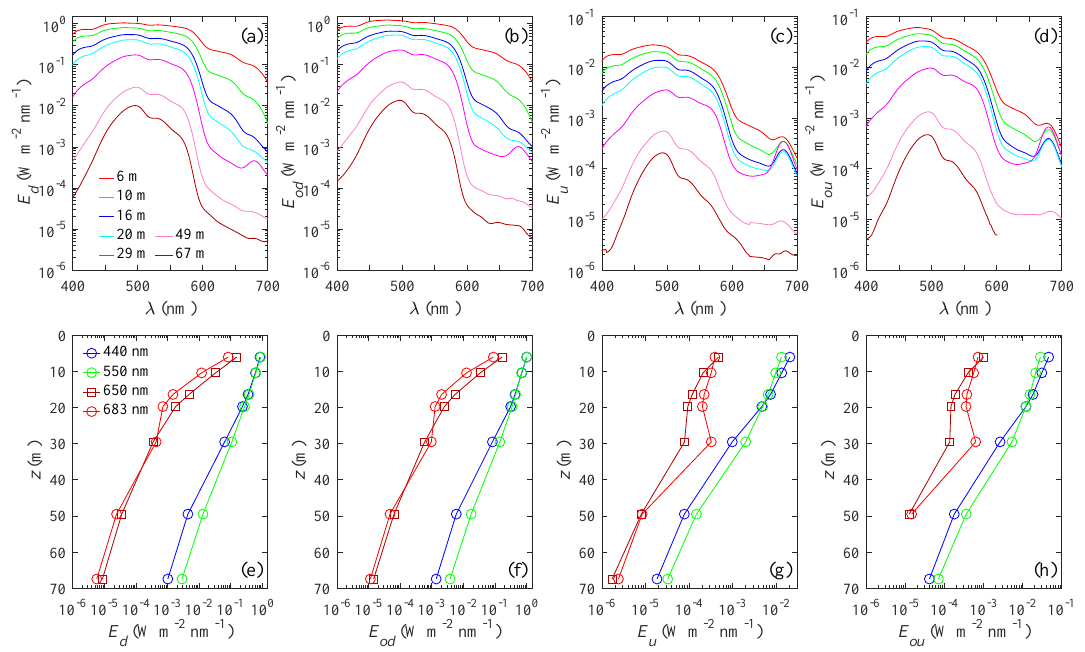
Figure 4. Spectra and vertical profiles of the irradiance quartet, E d ( a , e ), E od ( b , f ), E u ( c , g ), and E ou ( d , h ), measured at the station in the Guaymas Basin shown in Figure 2a. In panels ( a – d ) different colors represent the measurement depths as indicated in ( a ). In ( e – h ) different colors and symbols represent selected light wavelengths as indicated in ( e ).